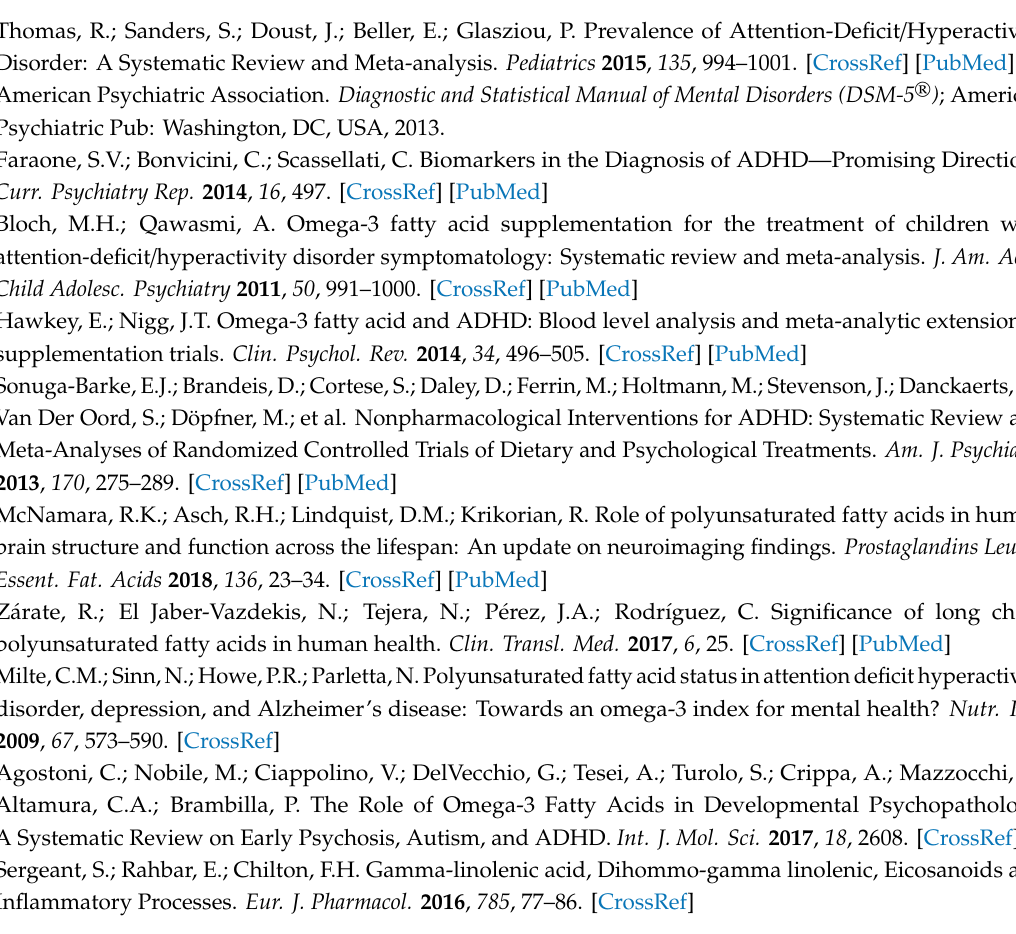
Table S1: Cognitive and clinical measures (means ± standard deviations) in participants groups.; Table S2: N-back task performance (means ± standard deviations).; Table S3a: HbO (a.u.) mean activations in each ROI and task condition in both groups. Table S3b: HbR (a.u.) mean activations in each ROI and task condition in both groups; Table S4a: Spearman’s rho values for correlations between HbO and blood fatty acid measures in the whole sample; Table S4b: Spearman coe ffi cients values for correlations between HbR and blood fatty acid measures in the whole